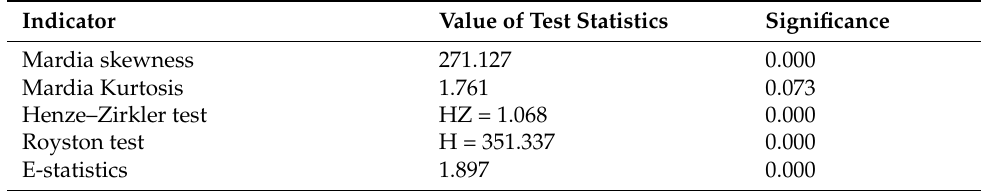
Table 6. Results of multivariable normality test.